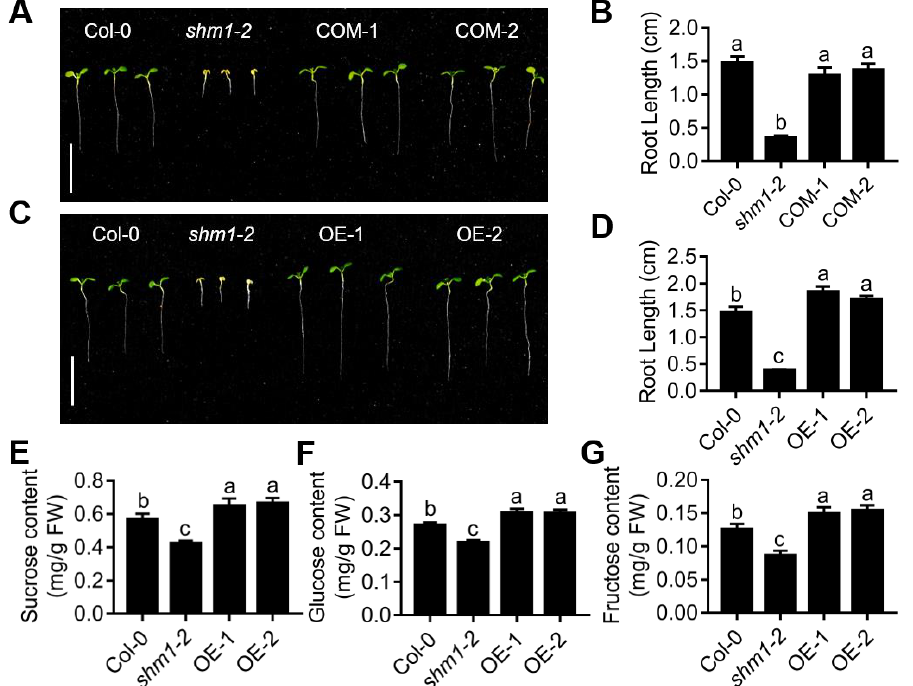
Figure 1. SHMT1 -promoted primary-root growth at sucrose-free conditions. ( A ) The root-growth phenotype of Col-0, shm1-2 and SHMT1 complementation lines (COM) grown on sucrose-free 1/2 MS medium for 8 days. ( B ) The primary-root length was statistically analyzed, as shown in ( A ). ( C , D ) The root-growth phenotype ( C ) and primary-root length ( D ) of SHMT1 overexpression lines (OE) grown on sucrose-free 1/2 MS medium for 8 days. Bars = 1 cm. Data presented were means ± SEM, n = 3 experiments; each experiment had 10 roots per genotype. ( E – G ) The contents of sucrose ( E ), glucose ( F ), and fructose ( G ) in Col-0, shm1-2 and SHMT1 OE seedlings grown on sucrose-free 1/2 MS medium for 8 days. Data presented were means ± SEM, n = 3 biological replicates. Different letters above error bars indicate significant difference at p < 0.05, using one-way ANOVA with Tukey’s test.